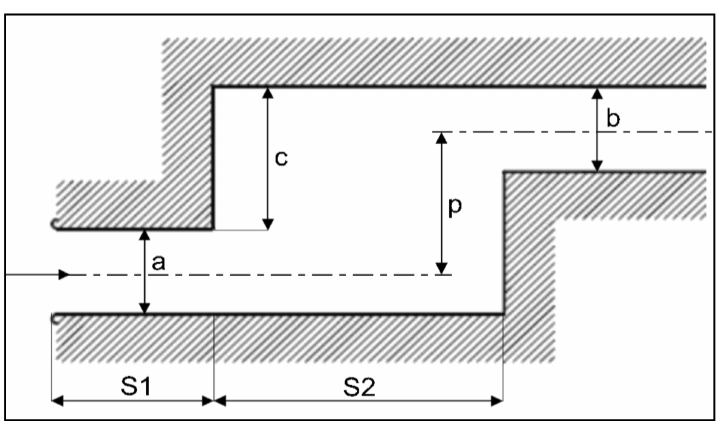
Figure 1. Adjusted test track